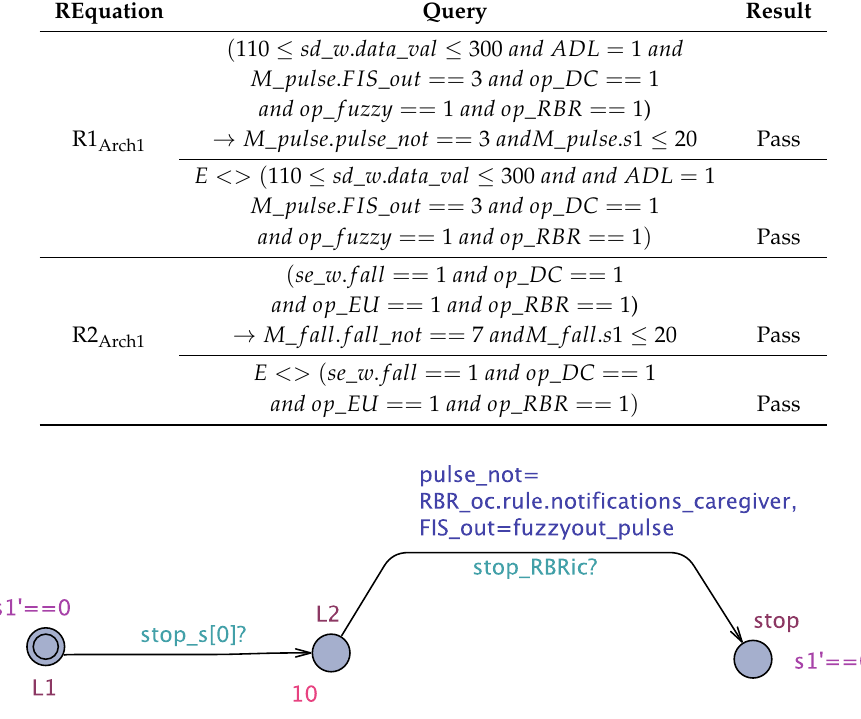
Figure 11. The monitor automaton for requirement R 1 Arch1 .